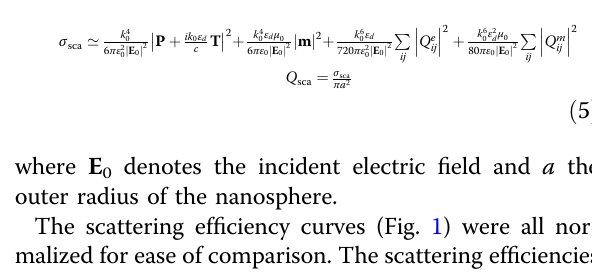
wave polarized along the x -axis. The center of the nanosphere was set as the origin for the coordinate system. The electric fi elds E ( r ) at every discretized point r inside the core-shell nanosphere were recorded using a 3D frequency-domain fi eld monitor. By introducing the polarization current J ( r ), the electric, toroidal, and magnetic multipole moments ( P , T , and m , respec-